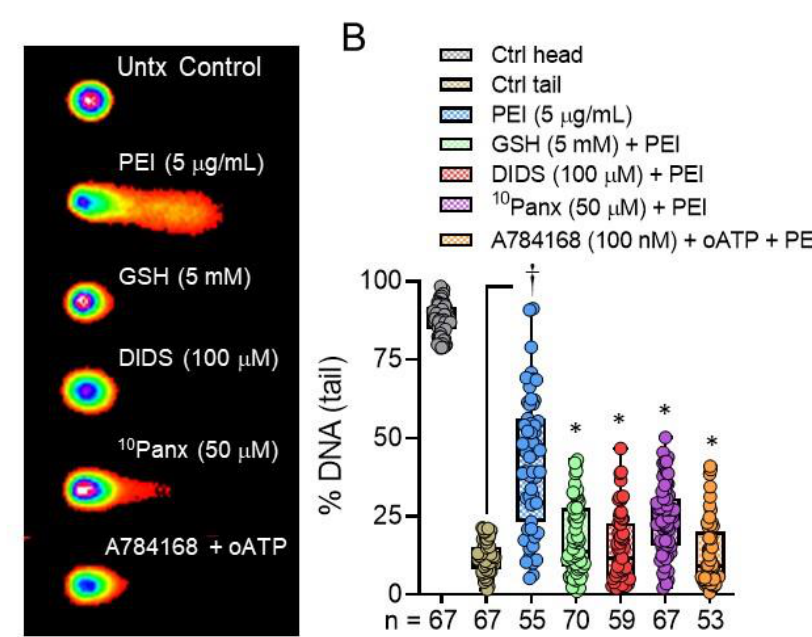
Figure 4. Results of comet assays showing that PEI (5 µ g/mL) causes DNA fragmentation. ( A ). Im- ages showing PEI induced comets before and after pretreatment with the oxidant scavenger GSH (5 mM), two inhibitors of ATP release (DIDS (100 µ M) and 10 Panx (50 µ M)) and a combination of inhibitors that block Ca 2+ uptake (oATP (300 µ M) and A784168 (100 nM)). ( B ). Measurements of % DNA present in the tails of comets exposed to PEI (5 µ g/mL; n = 55) before ( † p < 0.0001) and after pretreatment with GSH (5 mM; n = 70), DIDS (100 µ M; n = 59), 10 Panx (50 µ M; n = 67) and oATP (300 µ M) + A784168 (100 nM), n = 53 (* p < 0.0001). The Brown-Forsythe and Welch ANOVA followed by Dunnett’s T3 multiple comparison’s test was used to determine significant differences between